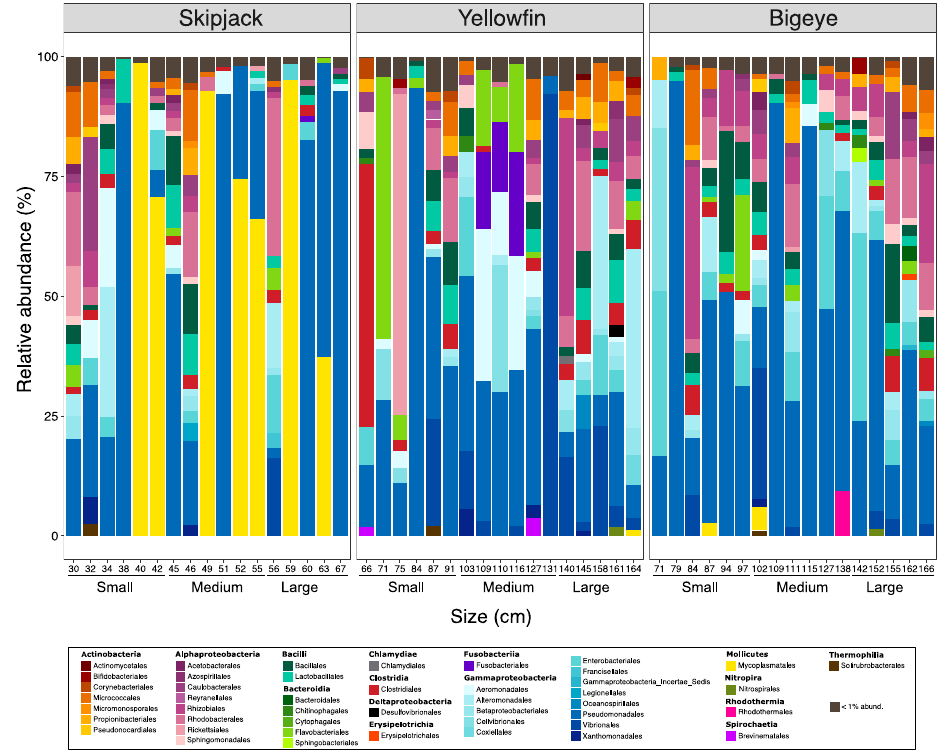
Figure 3. Relative abundances of the main bacterial classes in the gut of skipjack, yellowfin and bigeye tunas, in their size group (small/medium/large). Each bar corresponds to an individual fish. Bacterial classes showing a relative abundance lower than 1% were designated “<1% abund”. Table 2. Results of permutational ANOVAS (PERMANOVA, 999 permutations) performed on Bray-Curtis dissimilarity matrices to test the variation of bacterial community composition with respect to the size of the three tuna species. Bold values indicate a significant effect of the tested factor ( p < 0.05). SKIPJACK YELLOWFIN BIGEYE